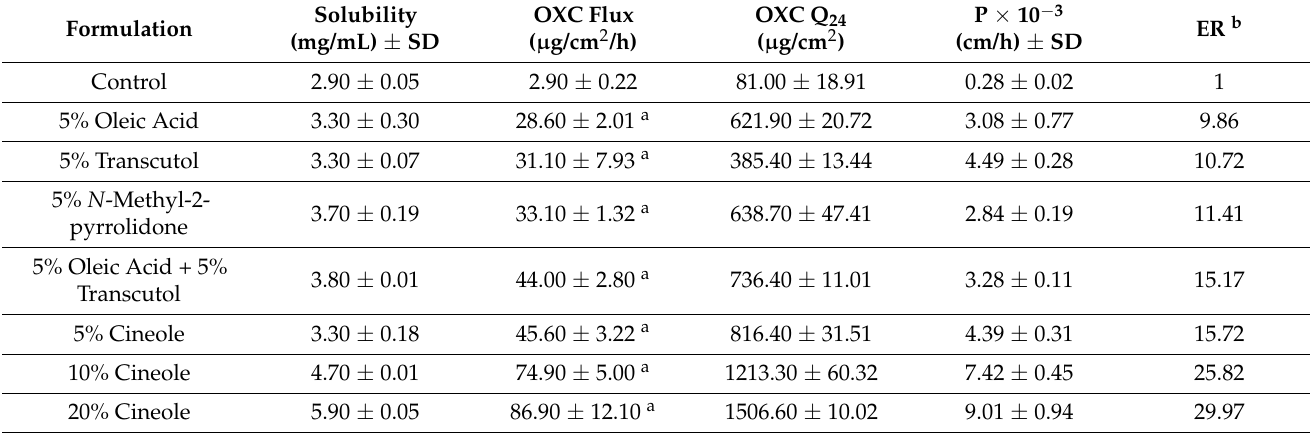
Table 4. Summary of the solubility and permeation parameters of OXC through human cadaver skin in tested formulations in presence or absence of penetration enhancers (n =